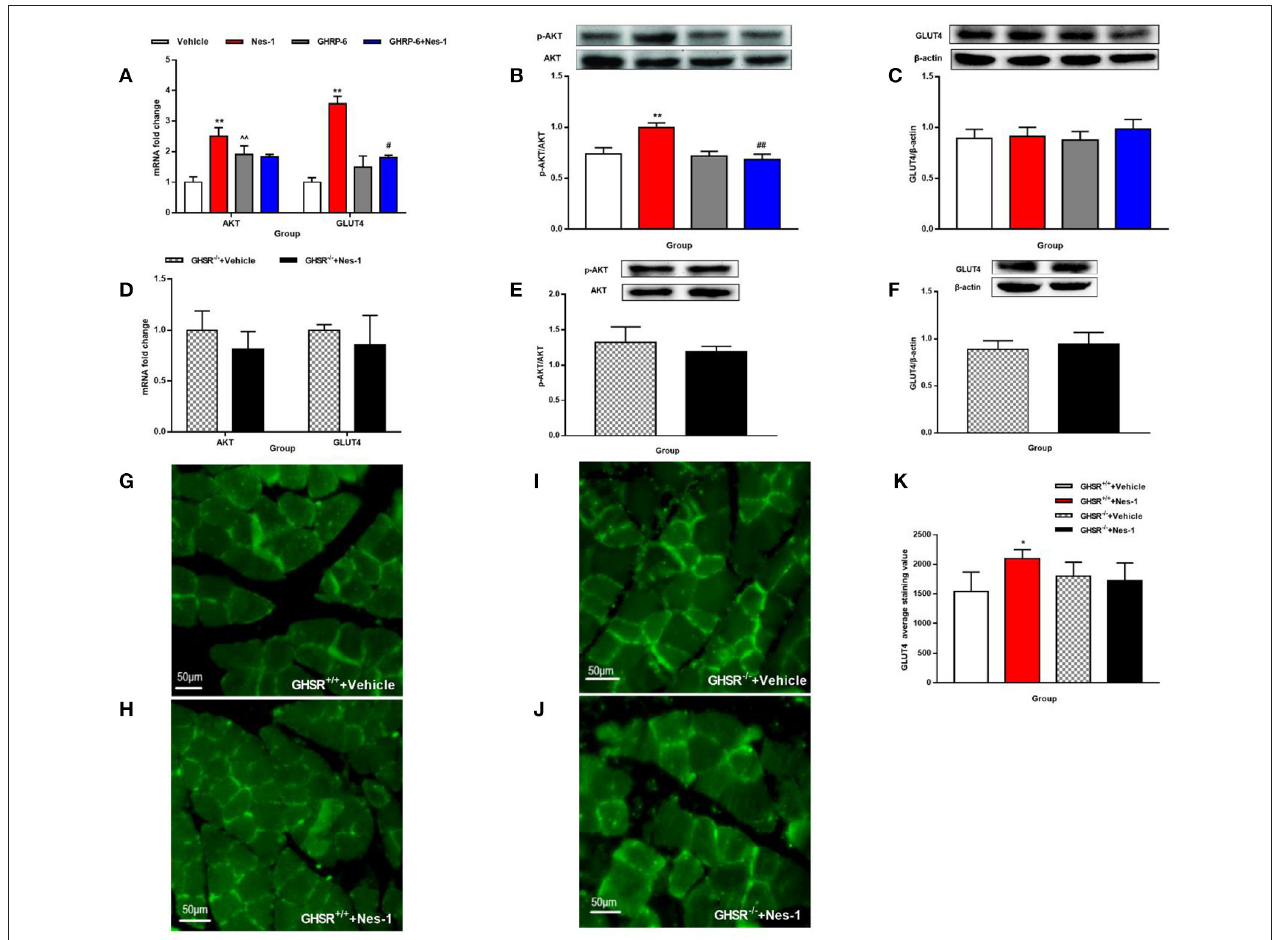
FIGURE 6 | GHSR mediated the effect of nesfatin-1 on AKT phosphorylation and GLUT4 membrane translocation in skeletal muscle. GHSR + / + mice fed NCD underwent chronic tail vein administration of vehicle, nesfatin-1 (Nes-1), [D-Lys3]-GHRP-6 (GHRP-6), and [D-Lys3]-GHRP-6 + nesfatin-1 (GHRP-6 + Nes-1) for 12 days. GHSR − / − mice fed NCD underwent chronic tail vein administration of vehicle and nesfatin-1 for 12 days. Insulin (2 IU/kg) was intraperitoneally injected into mice 10min before mice were sacrificed. (A,D) mRNA expression levels of AKT and GLUT4 detected by RT-PCR in skeletal muscle of (A) GHSR + / + and (D) GHSR − / − mice. (B,E) P-AKT and (C,F) GLUT4 protein levels detected by Western blotting were normalized to total AKT and β -actin, respectively. (B,E) P-AKT/AKT level in skeletal muscle of (B) GHSR + / + and (E) GHSR − / − mice. (C,F) GLUT4 level in skeletal muscle of (C) GHSR + / + and (F) GHSR − / − mice. (G,H) GLUT4 membrane translocation detected by immunofluorescence in skeletal muscle of GHSR + / + mice treated with (G) vehicle and (H) nesfatin-1. (I,J) GLUT4 membrane translocation detected by immunofluorescence in skeletal muscle of GHSR − / − mice treated with (I) vehicle and (J) nesfatin-1. (K) GLUT4 average staining value in skeletal muscle of GHSR + / + mice and GHSR − / − mice. n = 5/group; (D) GHSR − / − + Vehicle: n = 3, GHSR − / − + Nes-1: n = 4; (E,F) n = 3/group; (G–K) n = 3/group. Data are expressed as mean ± SEM. * P < 0.05; ** P < 0.01 for the effect of nesfatin-1 vs. vehicle; # P < 0.05, ## P < 0.01 for the effect of GHRP-6 + nesfatin-1 vs. nesfatin-1; ∧∧ P < 0.01 for the effect of GHRP-6 vs. vehicle. (A–C,K) One-way ANOVA was applied to analyze the statistical difference for multiple groups. (D–F) Student’s t -test was applied to analyze the statistical difference for two